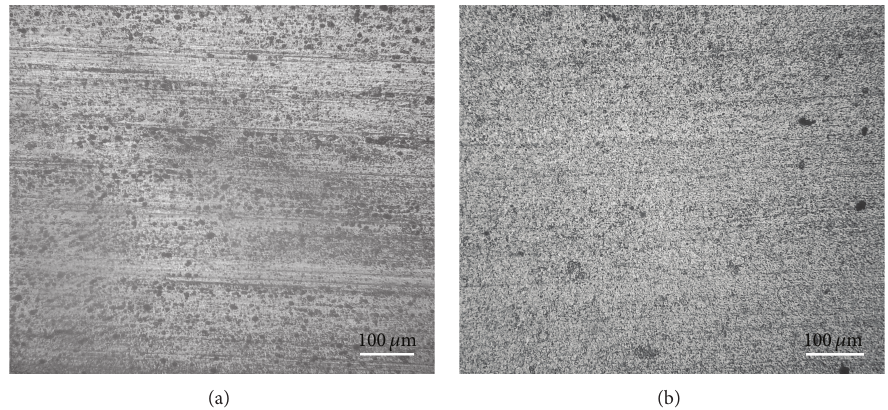
Figure 3: The layer surface structure: (a) c (H 2 SO 4 ) = 0.87 mol ⋅ L −1 , c (C 2 H 2 O 4 ) = 0.13 mol ⋅ L −1 , T = 12 ∘ C, U = 8.5 V, t = 15min. (b) c (H 2 SO 4 ) =